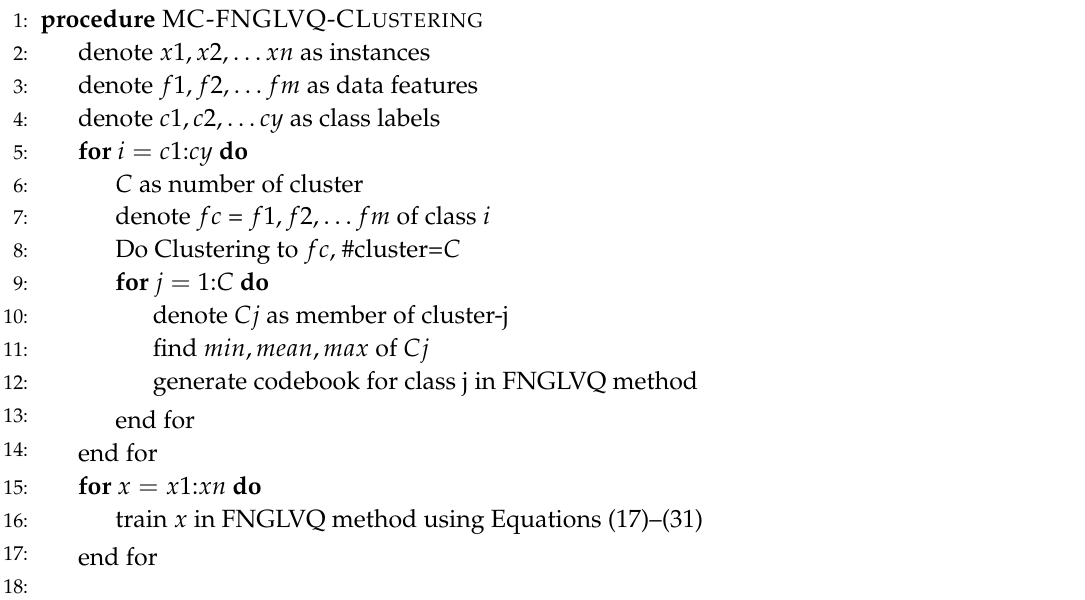
Algorithm 1 Multi Codebook Fuzzy Neuro Generalized Vector Quantization Using